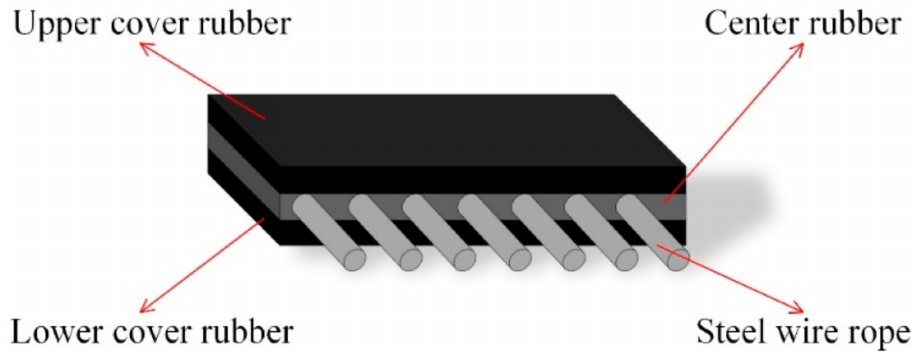
Figure 2. Sandwich structure of a conveyor belt crossed by steel